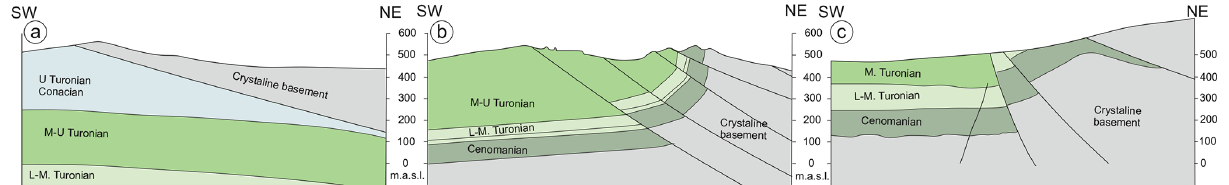
Figure 18. Schematic sections across the Lusatian Thrust at three localities, showing along-strike structure changes (based on Coubal et al., 2014). Location in Fig. 2.